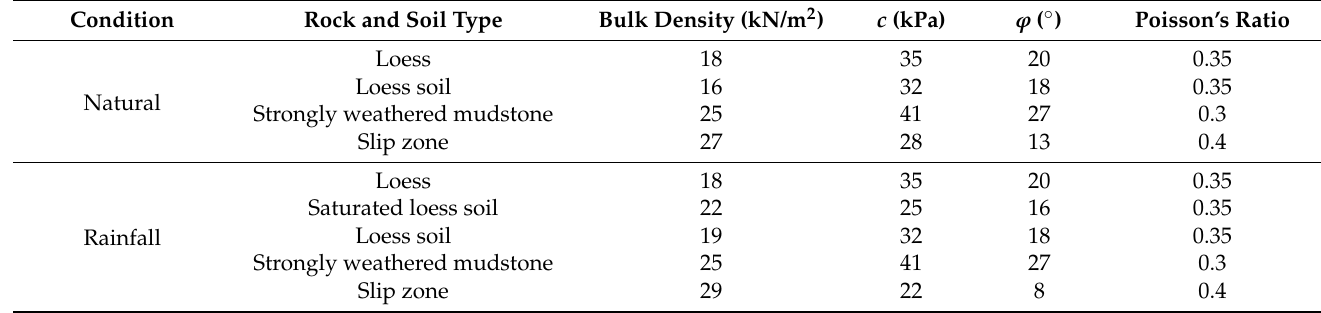
Table 4. Stability calculation parameters after landslide in the Tanshan Coal